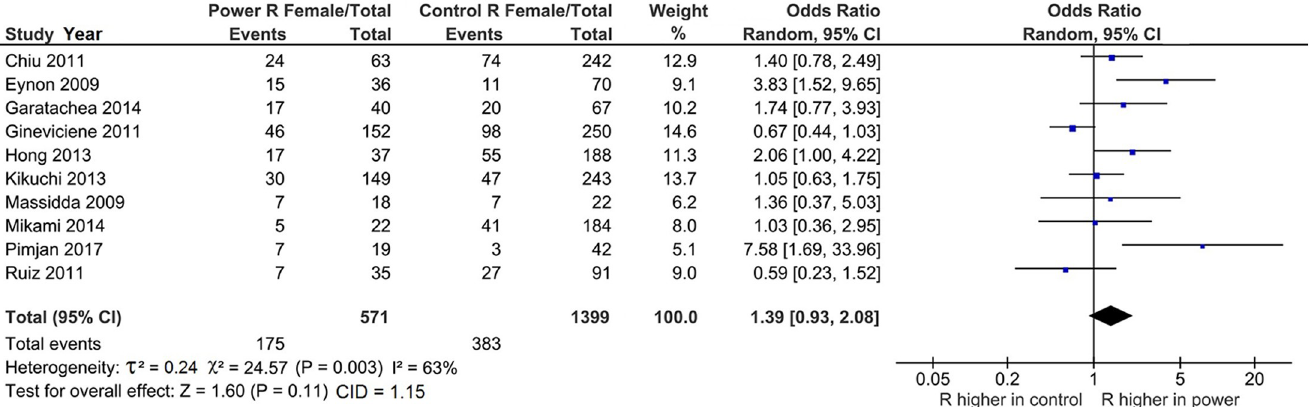
PLOS ONE | https://doi.org/10.1371/journal.pone.0217390 May 30,